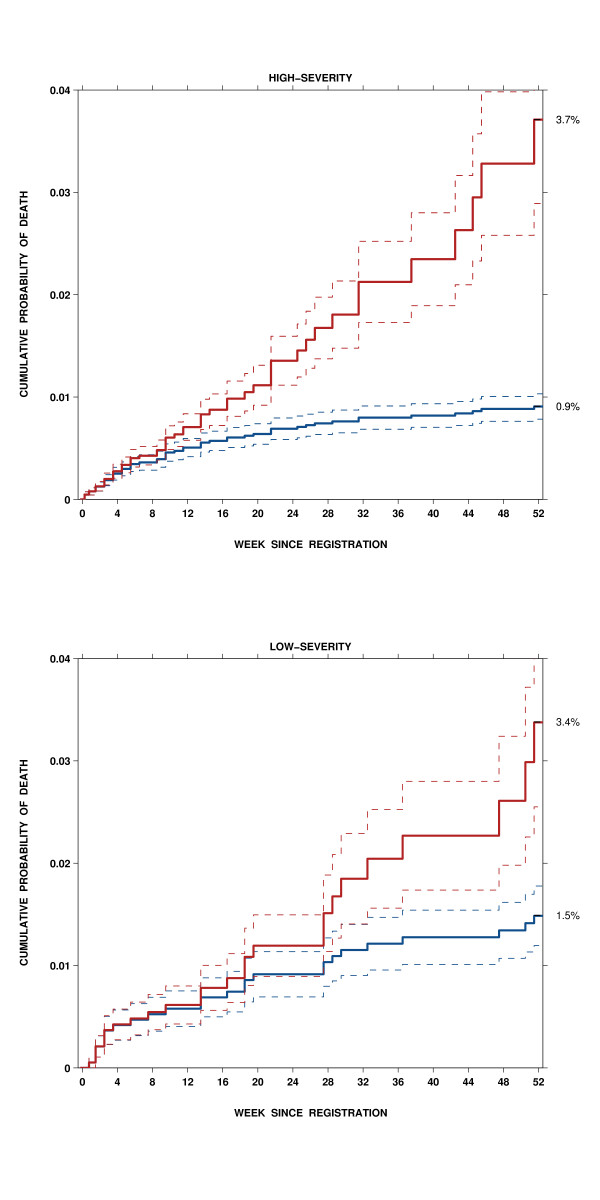
Estimated probabilities of preoperative death, as cumulative incidence function (blue) and Kaplan-Meier (red) and their standard errors, by week since registration in high-severity and low-severity group.